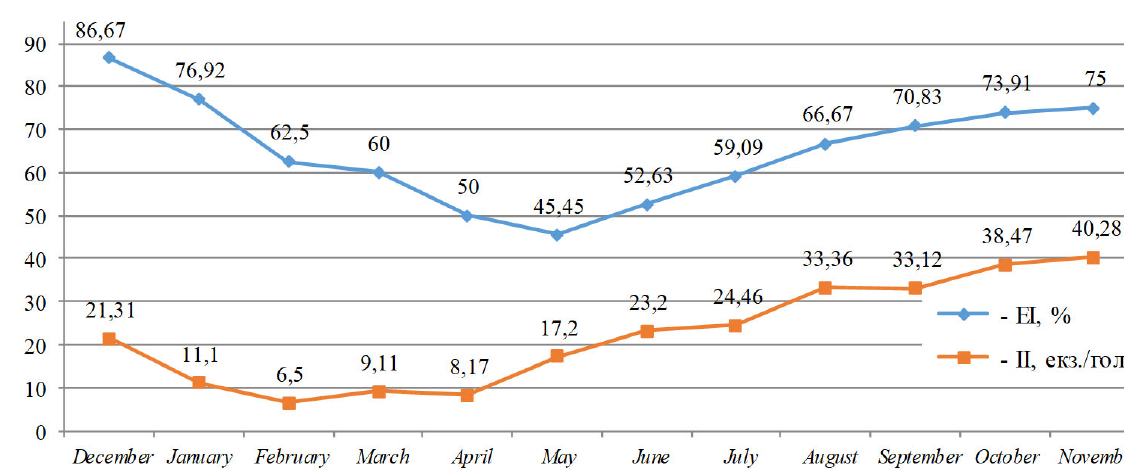
Fig. 4. Indicators of extensiveness and intensity of Haemonchosis invasion of sheep on the territory of Zaporizhzhia region farms during the